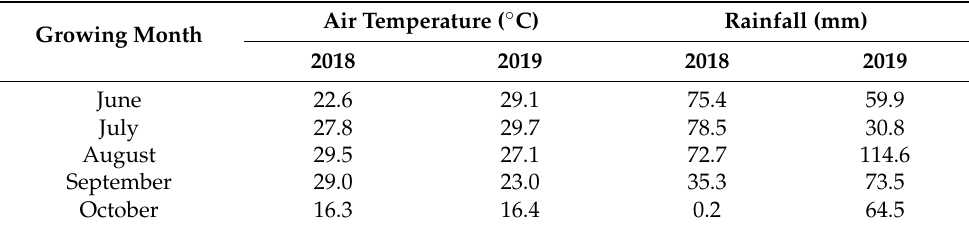
Table 1. Monthly mean air temperature and rainfall during the 2018–2019 soybean growing season in Xinxiang,